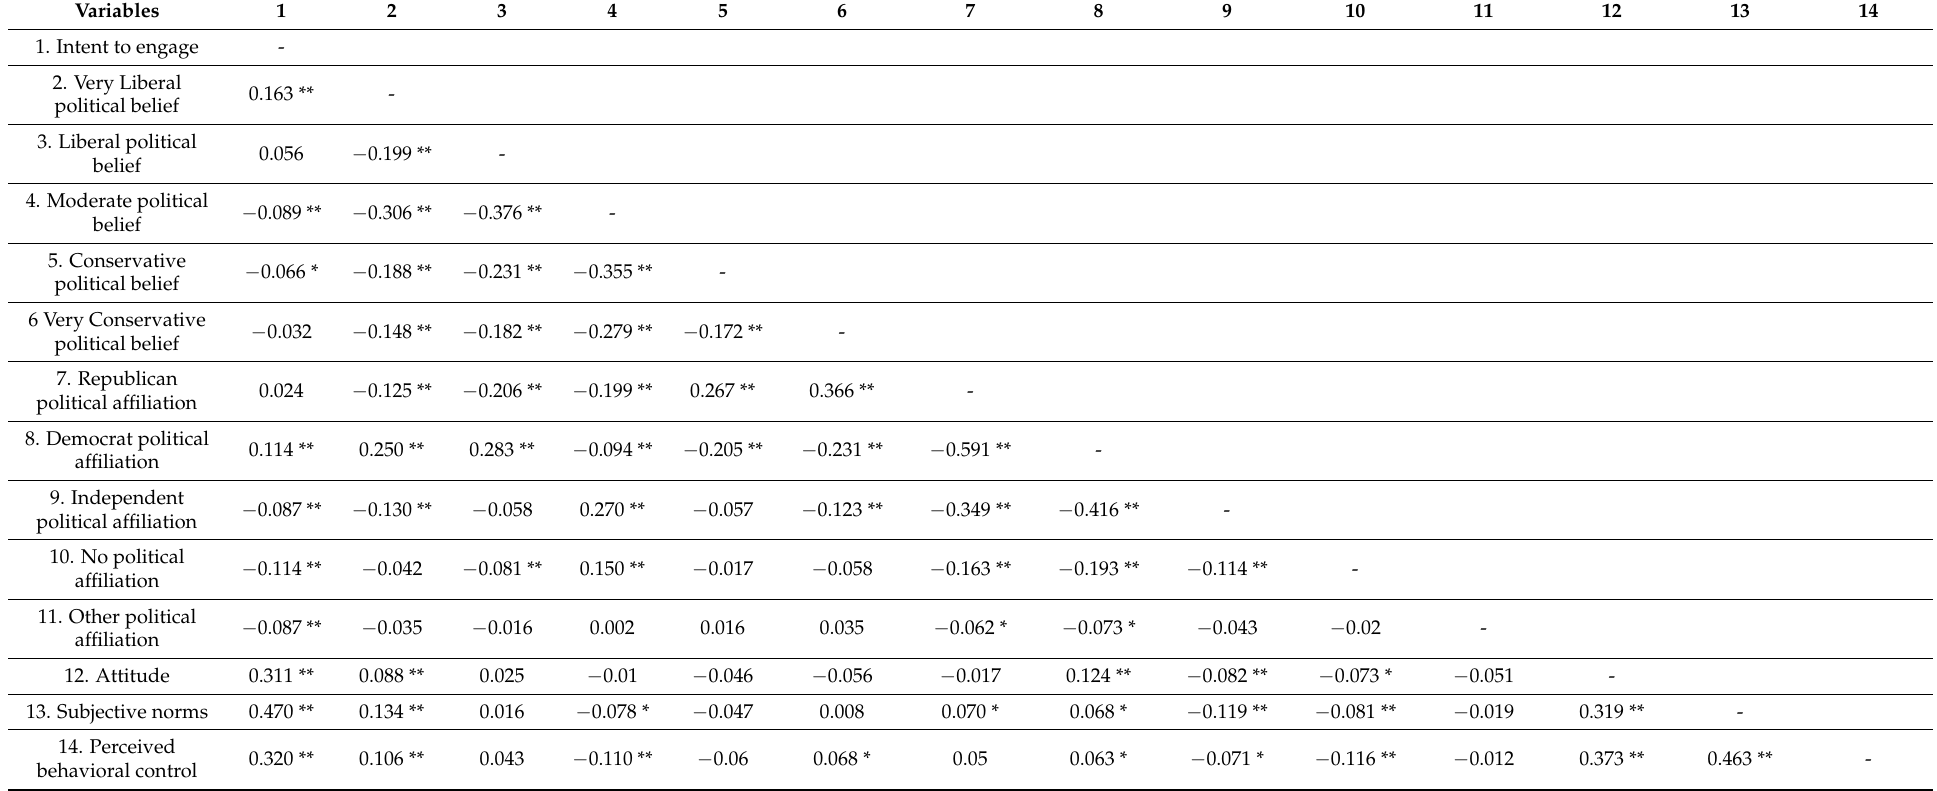
Table 5. Relationships between Political Affiliation, Political Ideology, and TPB Variables (N =